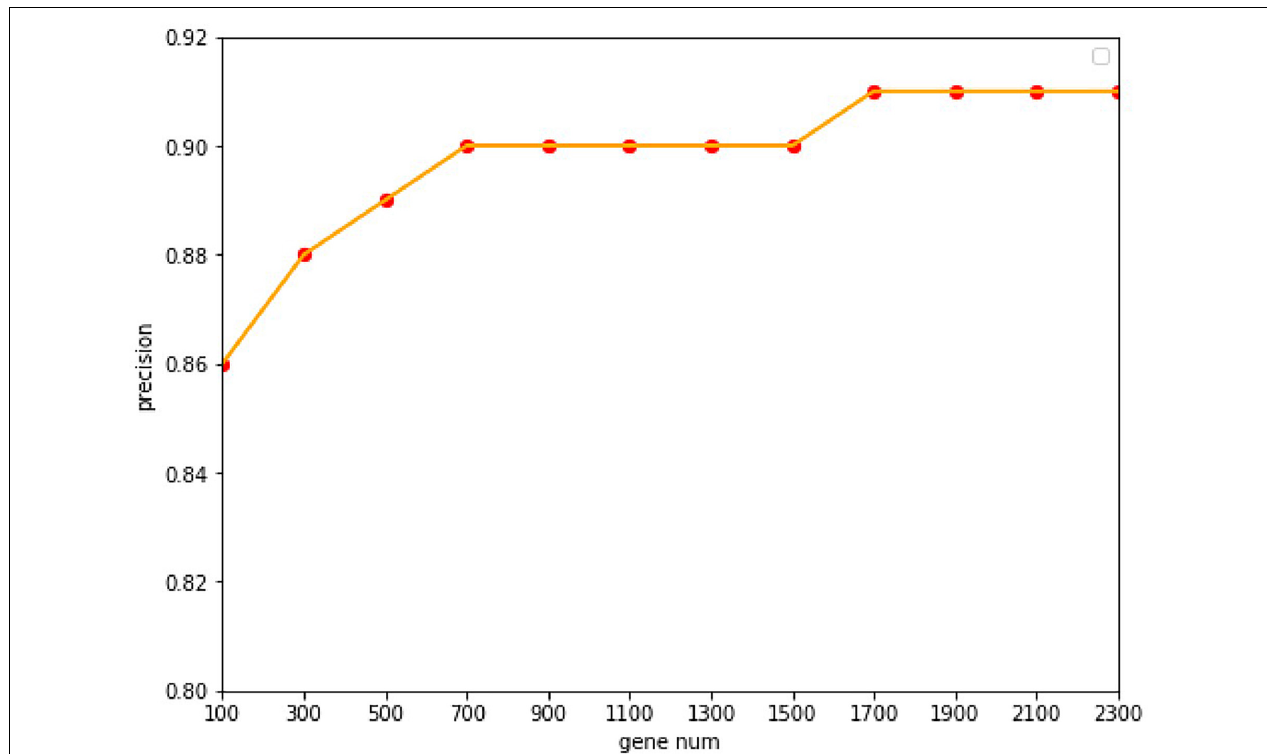
FIGURE 2 | The accuracy with the different of number genes. With a 10-fold cross-validation accuracy, the value of the accuracy is increasing up to 1,700 genes, after which it keeps stable with the value of 91.07%.